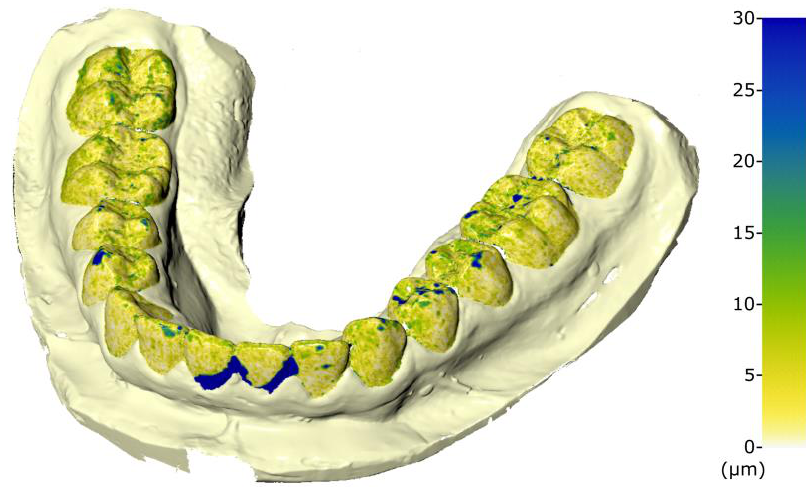
Figure 2. Superimposition of 2 impressions of the same cast, both acquired with the laboratory scanner. The color-map indicates its precision. Values in μm. Table 2. Results of the trueness study of the IOS. Mean and standard deviation for each scanning strategy, examiner, and session.